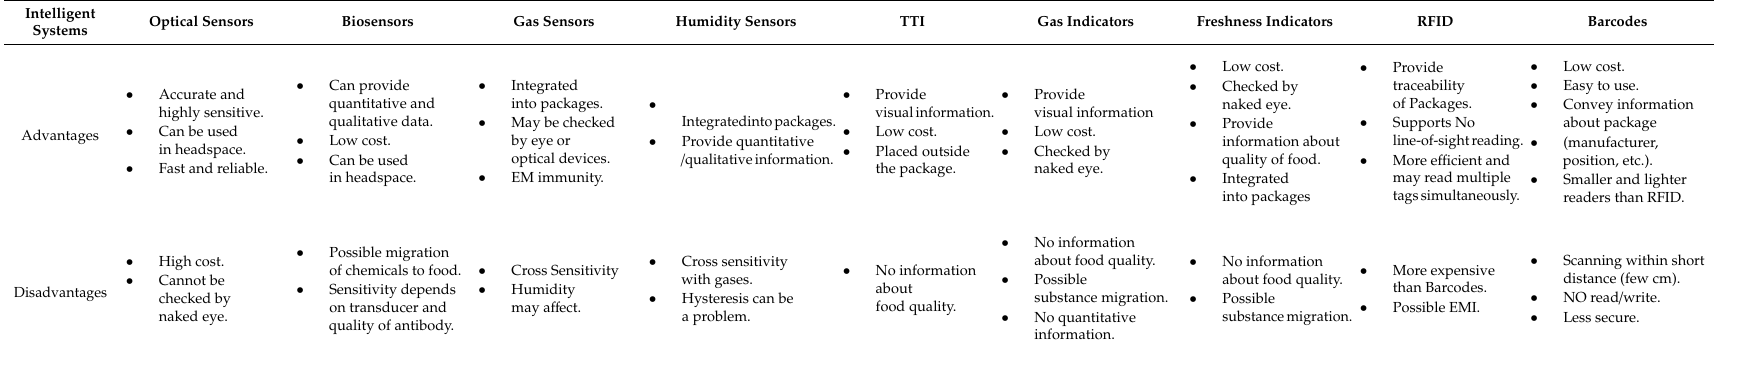
Table 8. Comparison between di ff erent intelligent